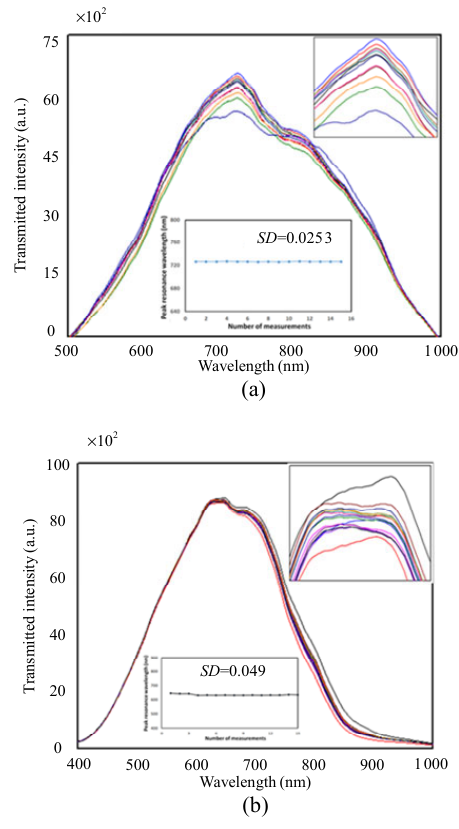
Fig. 15 Stability test: (a) Probe I and (b) Probe